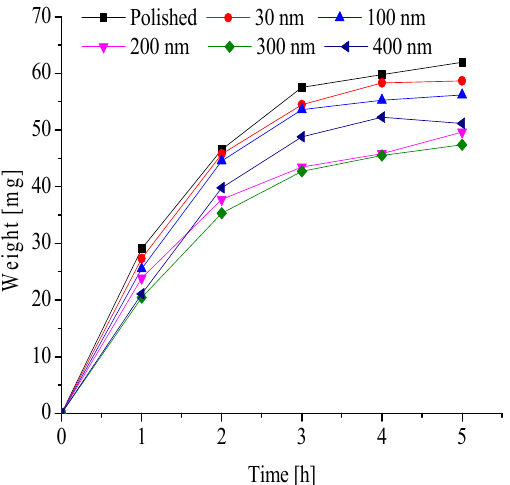
Figure 16. Variations of frost weight with different nanoporous diameters at T = − 5 °C, φ = 90%.